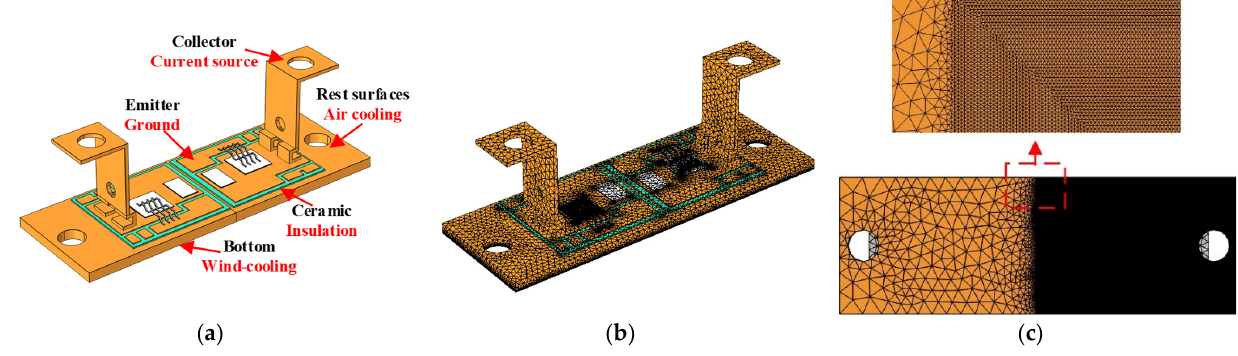
Figure 7. ( a ) FEM model; ( b ) meshed IGBT module; ( c ) mesh of baseplate. The meshed model is shown in Figure 7b, which consists of 1,152,643 domain ele ‐ ments, 216,192 boundary elements, and 7236 edge elements. To study the effect of bond wire lift ‐ off on the thermal resistance measurement, the bottom of the baseplate layer meshed with more free triangular distribution than other areas as in Figure 7c, which con ‐ sist of 164,632 boundary elements and 1619 edge elements. The material properties of the FEM model are shown in Table 2. The conduct charac ‐ teristic of IGBT die r die is temperature ‐ dependent in different current levels. Hence, the electrical conductivity of die σ die could be obtained based on the die temperature [27], where l and A are the height and conduct area of IGBT die as in Equations (14) and (15).